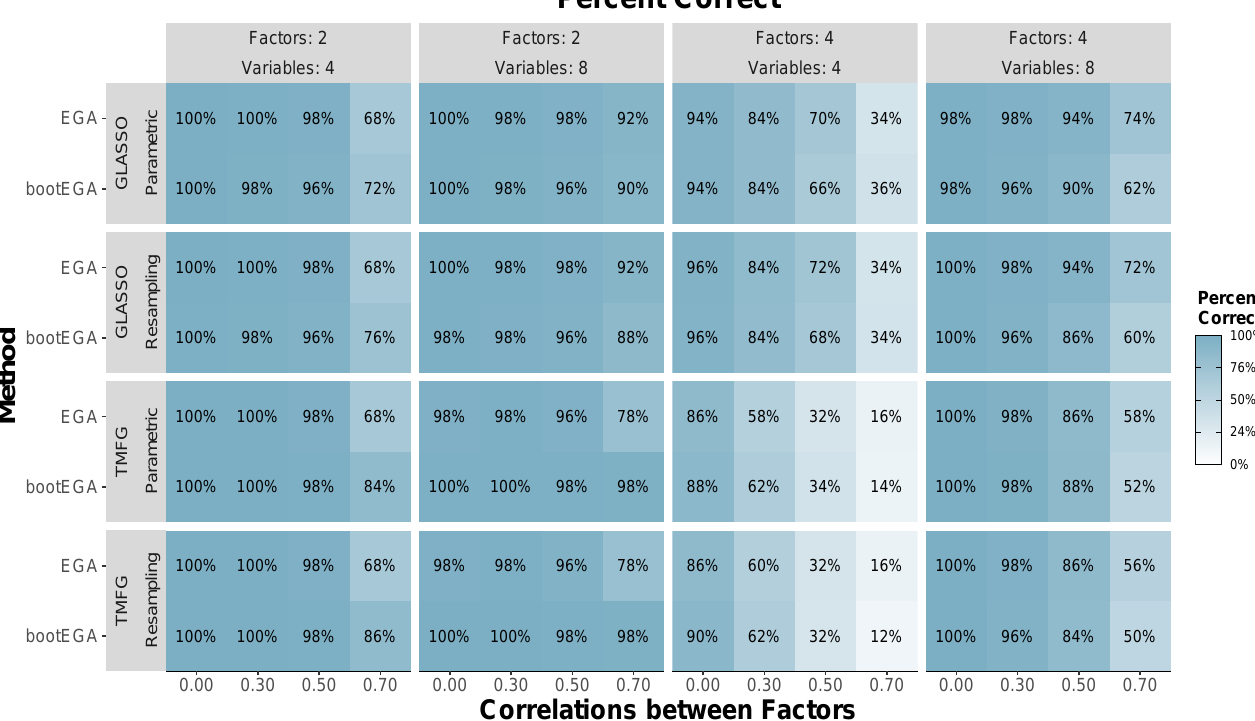
Figure 1. Accuracy of the median bootEGA network structure and empirical EGA. It is noteworthy that there was no effect of sample size given that the number of cases tend to affect most methods [34]. Digging into our results, there was an apparent ceiling effect across conditions that might have limited the effect of sample size. Specifically, there only appeared to be a performance difference when there were less favorable conditions: few variables (4) and large correlations between factors